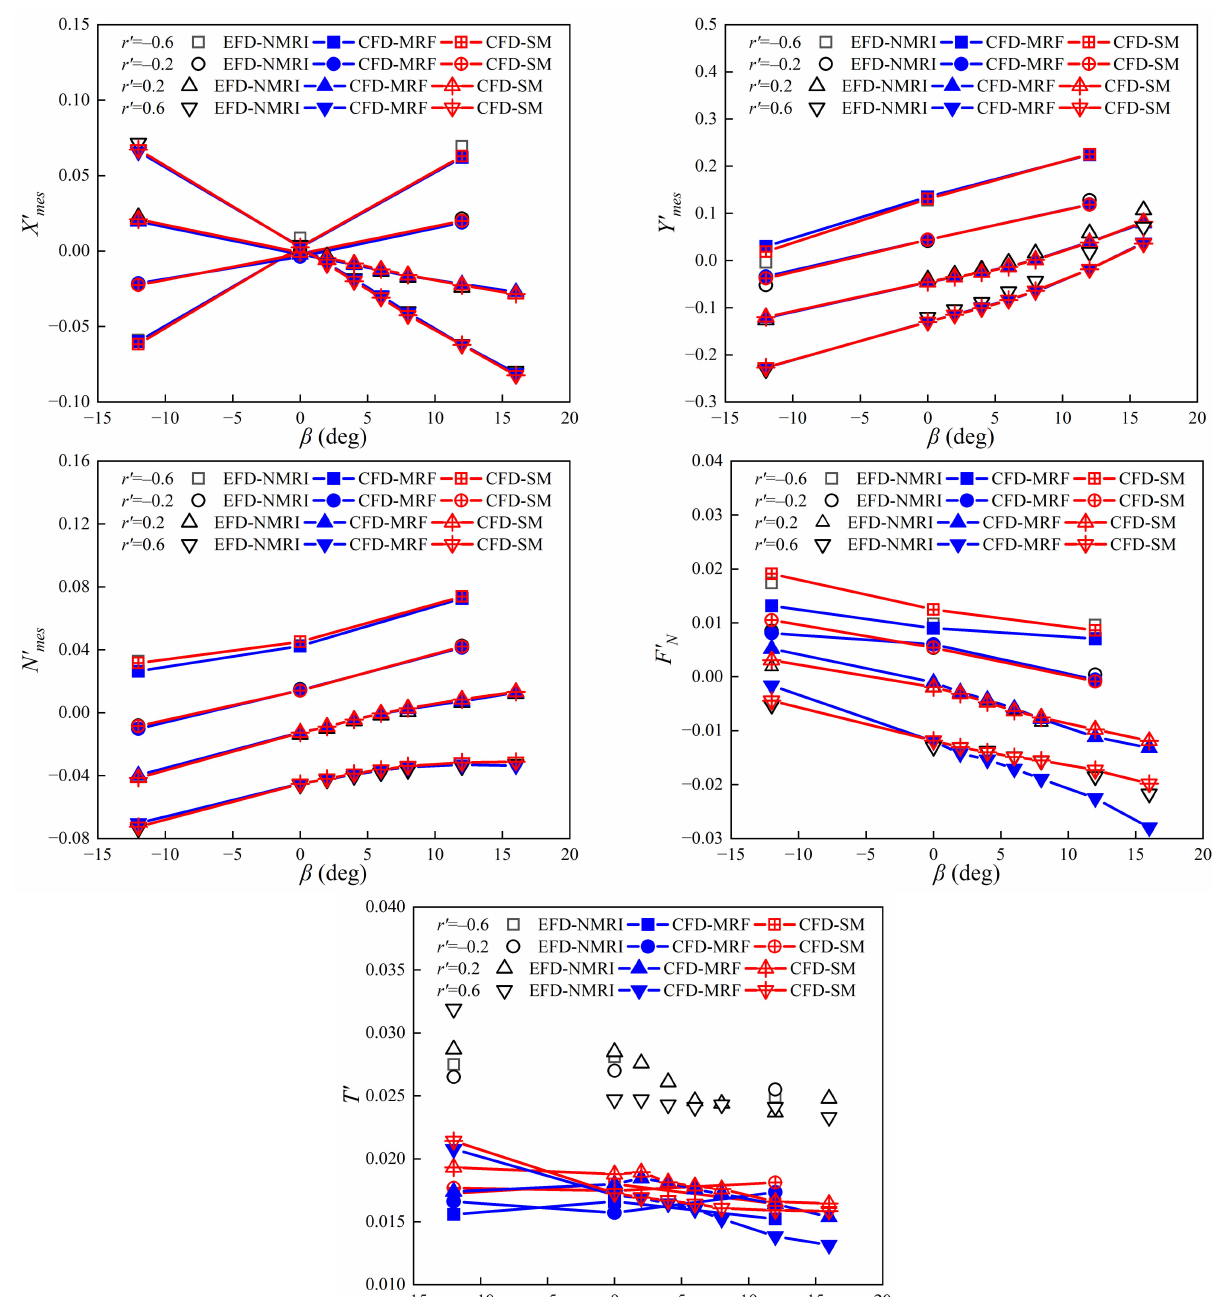
Figure 12. Hydrodynamic quantities in CMTs ( β (cid:54) = 0 ◦ ) obtained from experiments and